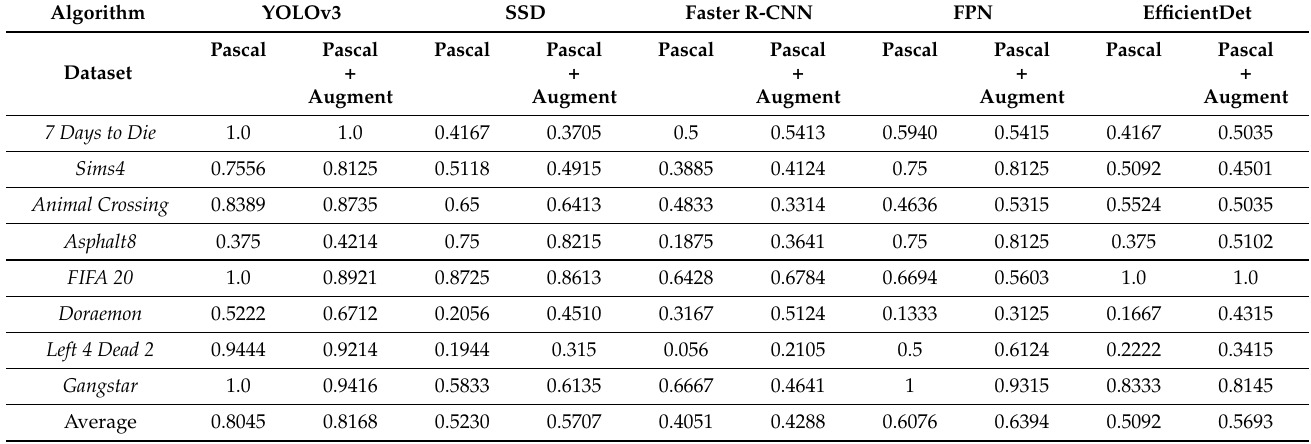
Figure 6. The augmented images from Pascal VOC: ( a ) is the sampled images from Pascal VOC dastaset, ( b ) is produced by flow-based image abstraction with coherent lines [37], ( c ) is produced by color abstraction using a bilateral filter [38] and ( d ) is produced by deep cartoon-styled rendering [39]. Table 16. The comparison of mAPs of the object detection algorithms between the VOC dataset trained with Pascal and retrained using augmented